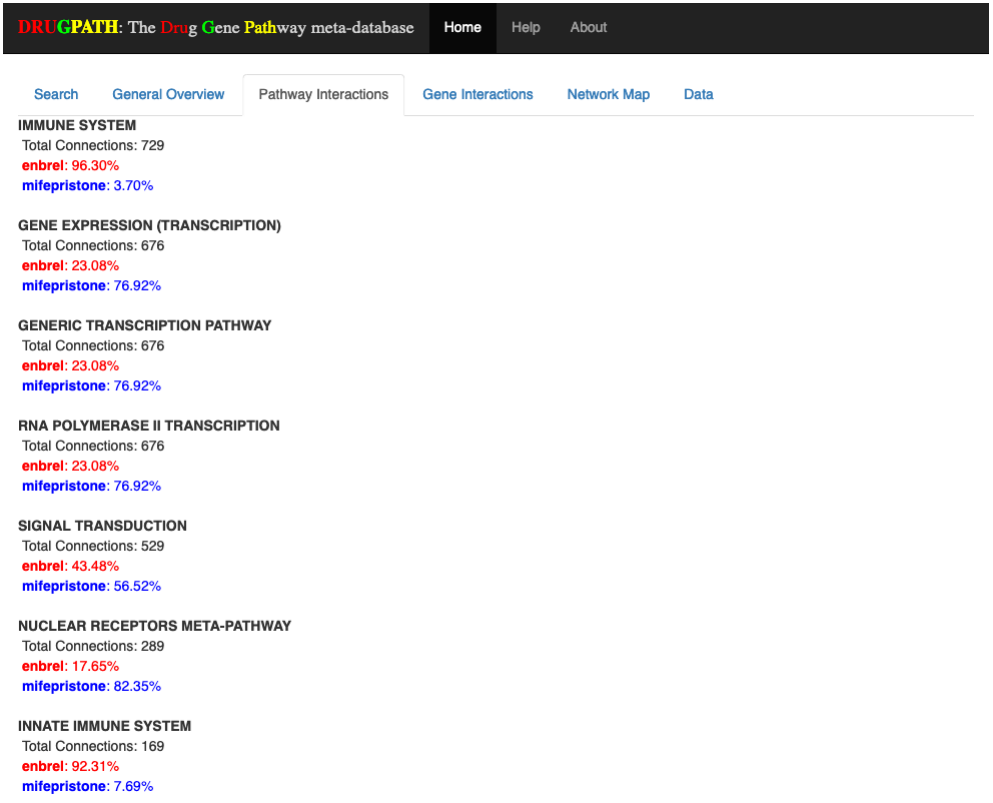
Figure 8. First few pathway interactions between enbrel and mifepristone.